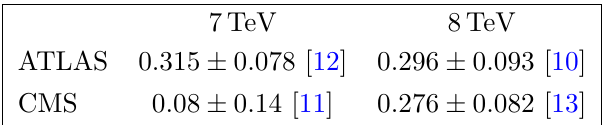
Table 1 . Selected measurements of the spin correlation coe(cid:14)cient C kk in the helicity basis by the ATLAS and CMS